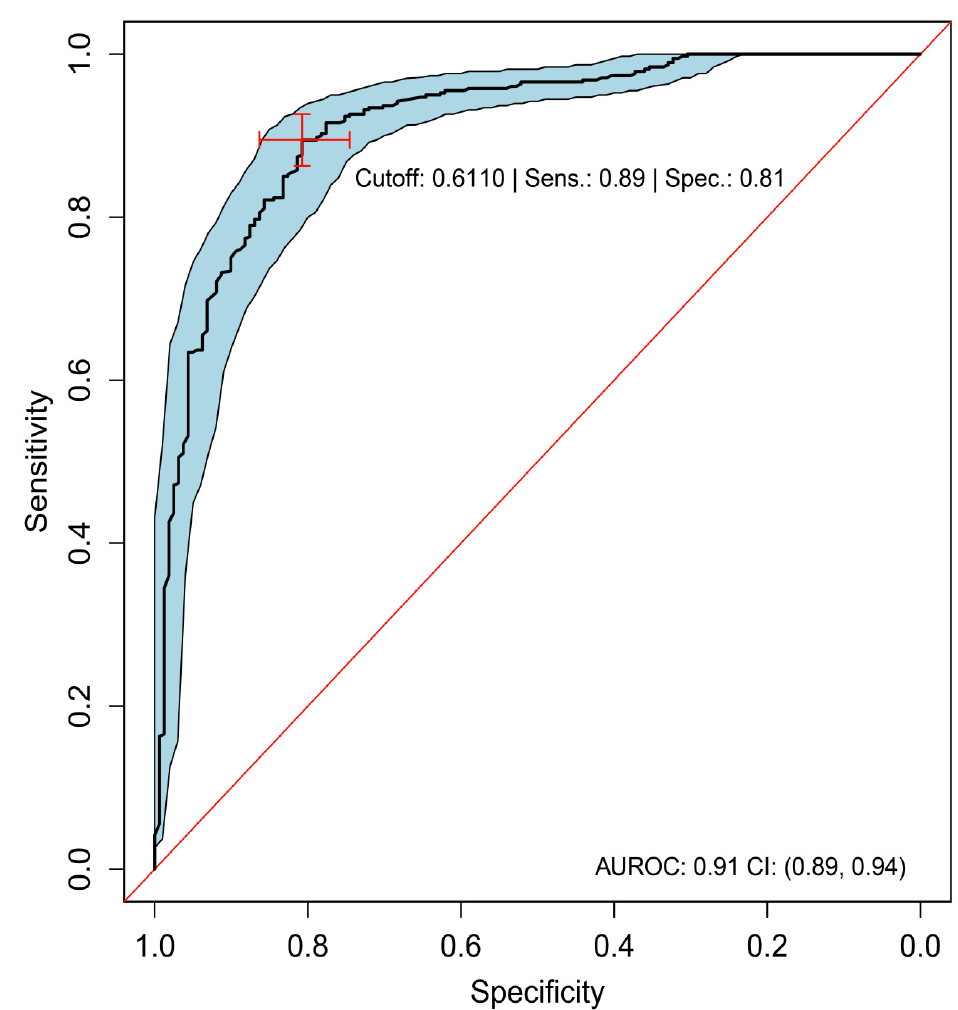
Figure 3. ROC analysis of predominantly classic versus occult (best-tuned performance). Sensitivity versus specificity for all possible ROC cutoff points with respect to the predicted occult scores in HARBOR, including 95% CIs (bootstrapped). The location of the red crosshair indicates the operating point of the model. AUROC, area under the receiver operating characteristic; FA, fluorescein angiography; NEG, negative; POS, positive; ROC, receiver operating characteristic; Sens, sensitivity; and Spec, specificity.